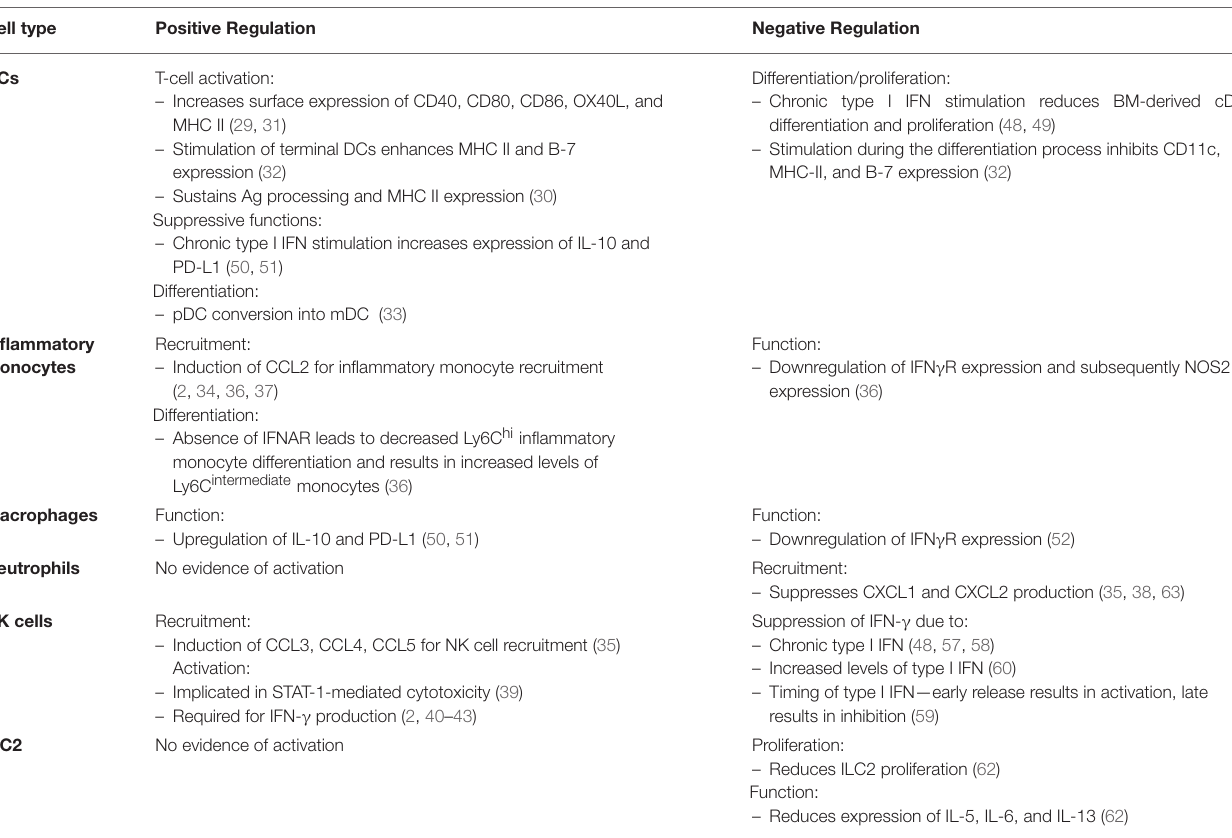
TABLE 1 | The role of type I IFN in regulating the antiviral innate immune